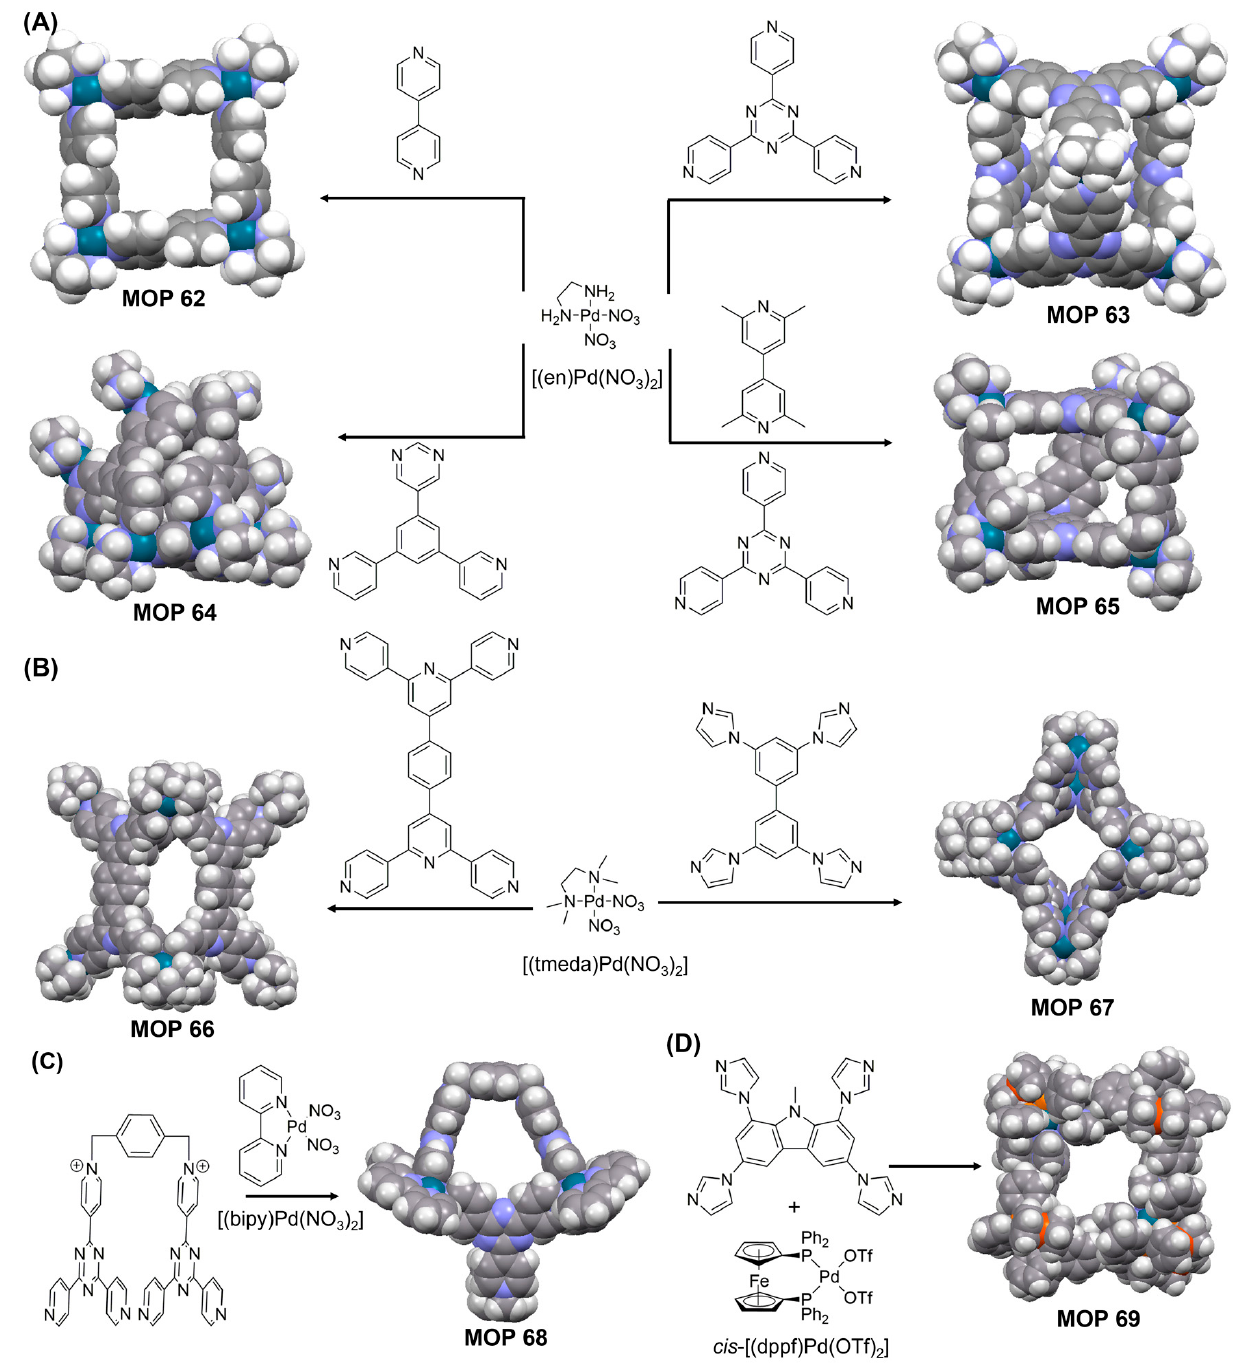
Figure 24. (A) Reaction of [(en)Pd(NO 3 ) 2 ]with rigid-oligo pyridines produce N-donor based MOPs 62, 63, 64 and 65. ( B ) Reaction of [(tmeda)Pd(NO 3 ) 2 ] with rigid-oligo pyridines/pyrimidines gave N-donor based MOPs 66 and 67. (C) Reaction of [(bipy)Pd(NO 3 ) 2 ] with rigid-oligo pyridine produces N-donor based MOP 68. (D) Reaction of cis -[(dppf)Pd(OTf) 2 ] with rigid-oligo pyrimidine produces N-donor based MOP 69. Pictures showing the examples of these ligands and the X-ray crystal structures of the corresponding MOPs. Reprinted by permission from Refs. [60,61,63,188–192]. Copyright 1990, 2000, 2005, 218, 2019 from American Chemical Society. Copyright 1995 from Nature Publishing Group. Copyright 2017 from Wiley-VCH.